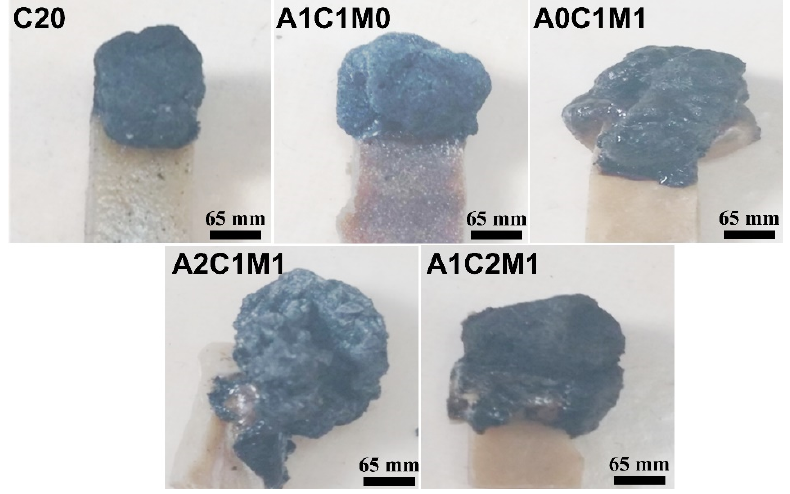
Figure 1. Digital photos of PLA and flame-retardant PLA composites after LOI tests.